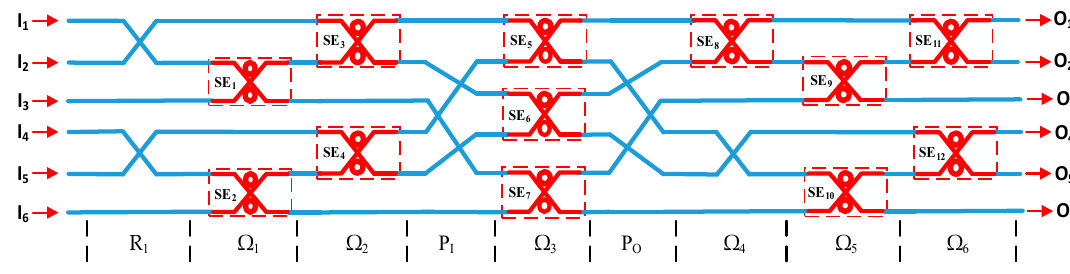
Figure 4. 6×6 Optimized optical switch architecture with 12 OSEs.